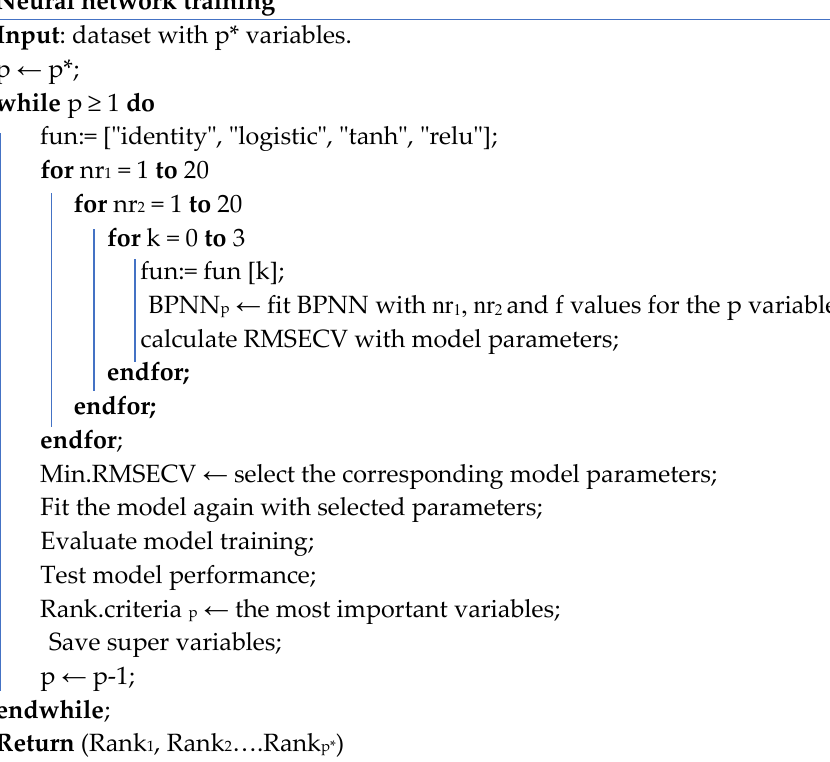
Figure 5. Pseudo ‐ code to train a neural network and select the top variables. Figure 5. Pseudo-code to train a neural network and select the top